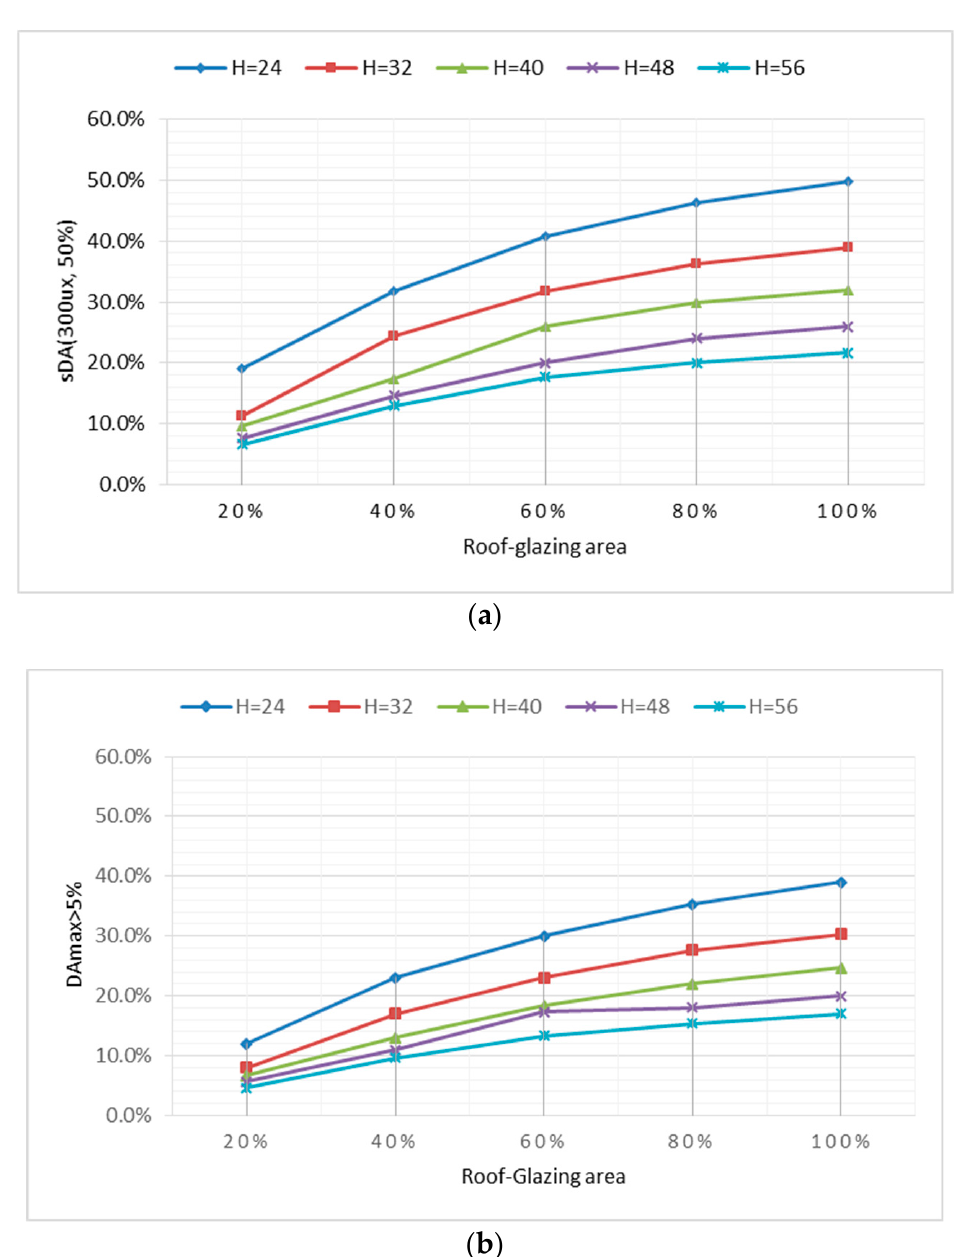
Figure 4. Daylighting-performance comparison of building height. ( a ) sDA(300, 50%) values in different building heights; ( b ) DA_MAX > 5% values in different building heights.